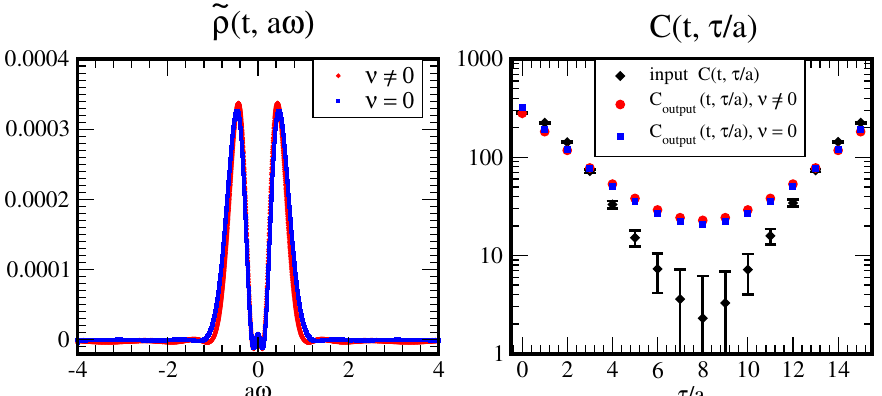
Figure 15 . (Left) the obtained spectral function (Right) the comparison plot between the input C ( t; (cid:28)=a ) and C output ( t; (cid:28)=a ). where e = 1 i